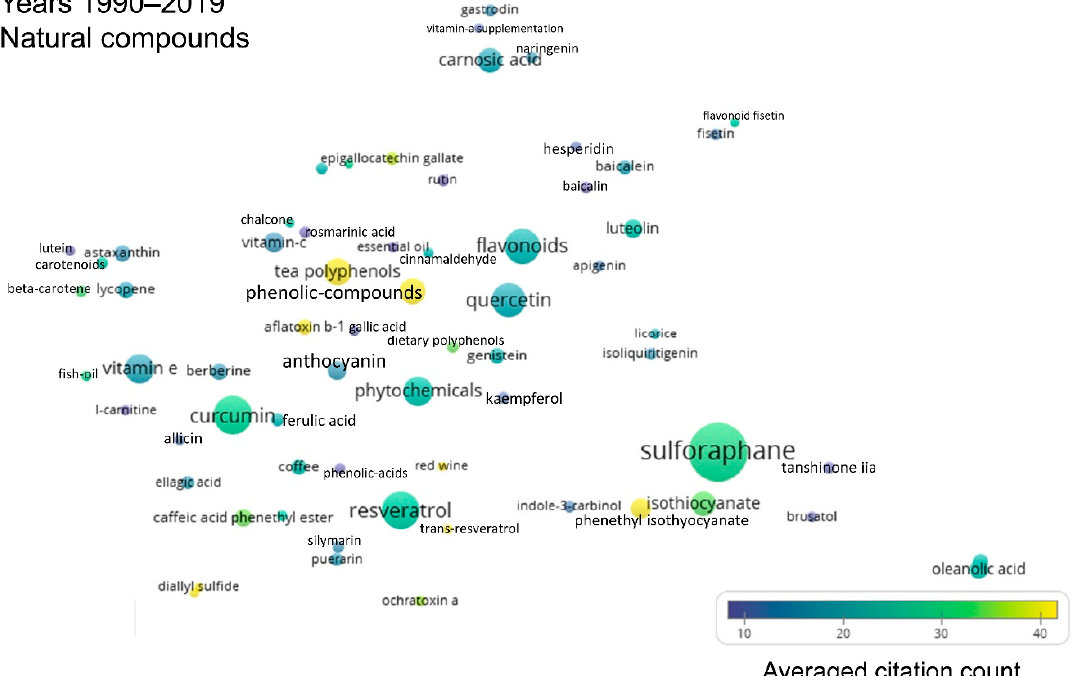
Figure 9. Term map for natural products related to Nrf2 for years 1990–2019. Bubble map showing the visualization of 66 natural product-related terms that appeared in at least 10 papers published between 1990 and July 2019. For explanations on bubble size, color and proximity, see the legend of Figure 2. All the terms visualized are listed in Table S10, along with their respective occurrence frequencies and averaged citations (average number of citations received by the documents in which a term occurs).